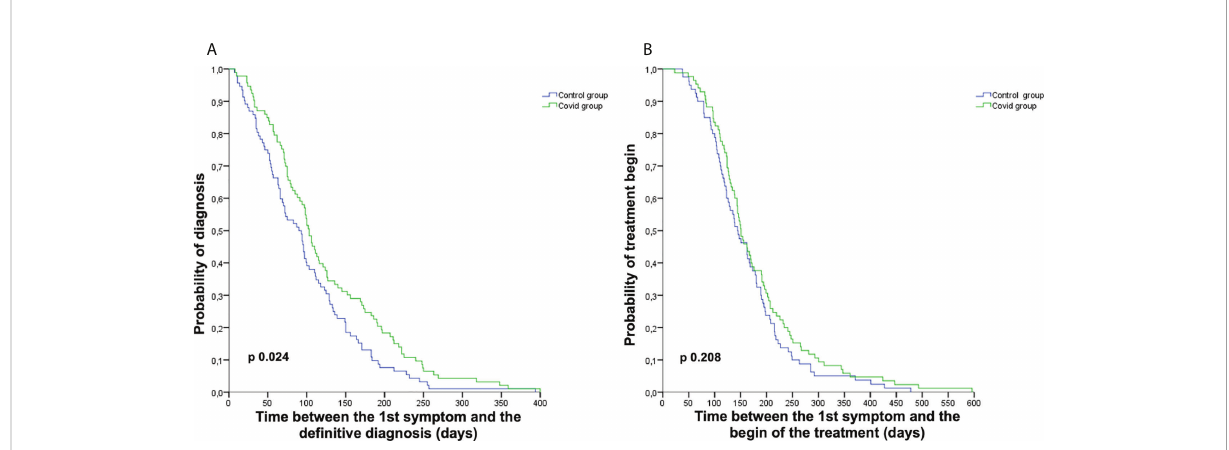
FIGURE 2 Kaplan – Meier curves representing diagnostic and treatment delay. Kaplan – Meier curves representing the time from the fi rst symptom to de fi nitive diagnosis (A) and from the fi rst symptom to the start of the fi rst treatment (B) in the Covid group (green) and the Control group